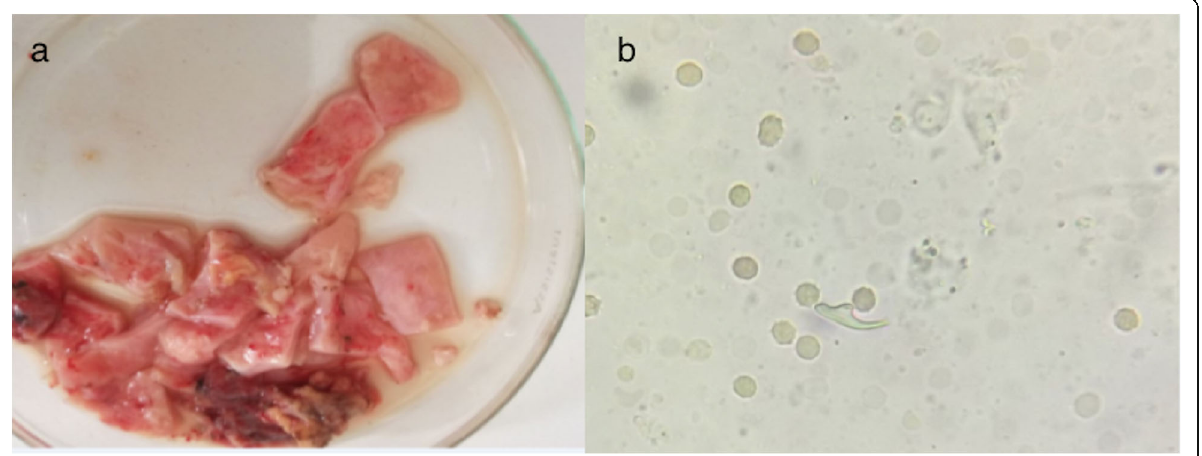
Fig. 3 a Membrane of the emptied cyst. b Echinococcus granulosus hook under an optical microscope (×